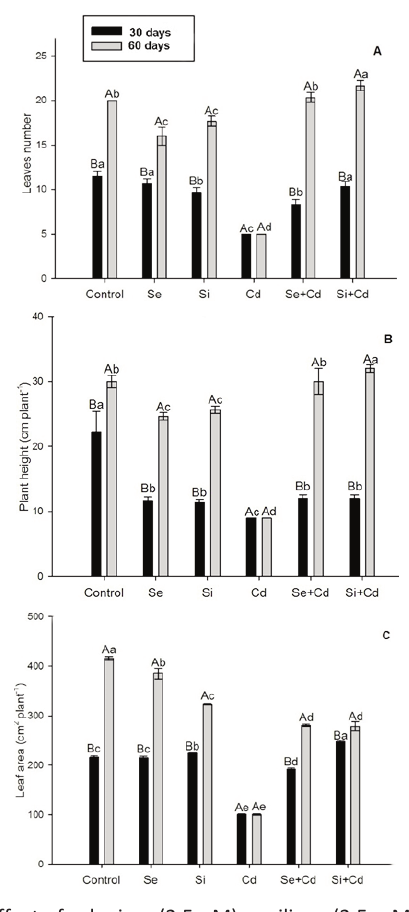
Fig. 3 - Effect of selenium (2.5 μM) or silicon (2.5 mM) on leaves number (A), plants height (B) and leaf area (C) of potato plants grown in cadmium presence (50 μM) at 30 and 60 days after application of the treatments. Different lower- case letters indicate significant differences between treatments in same collect. Different upper case letters indicate significant differences between collects for same treatment.